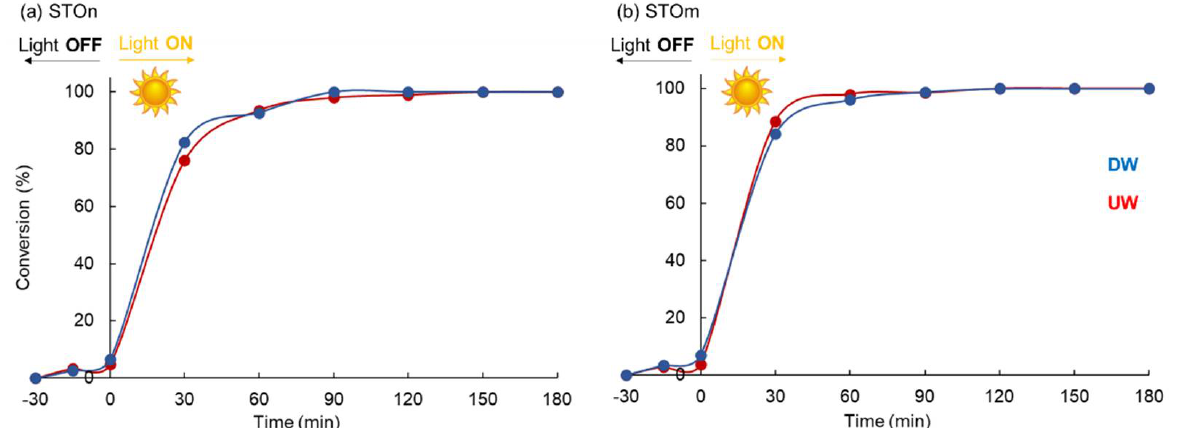
Figure 10. Effect of water matrix on DCF photodegradation by STOn and STOm (UW = ultrapure water; DW = simulated drinking water).